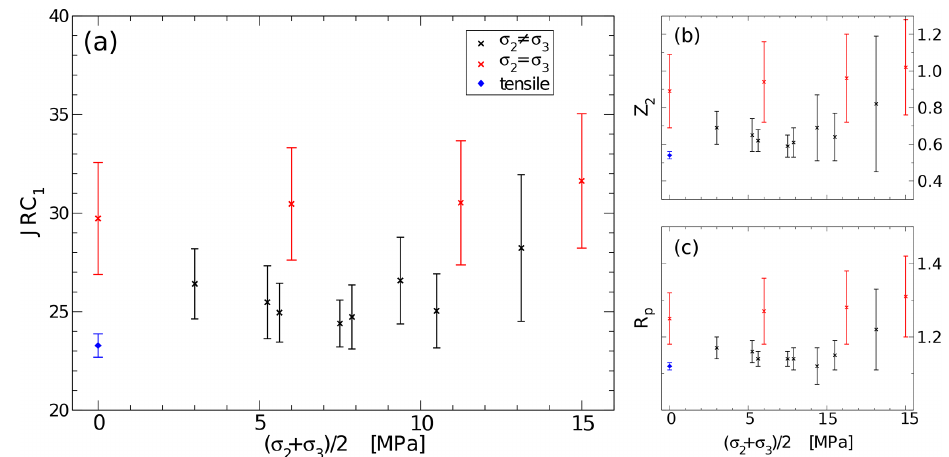
Figure 6. Geometric roughness measures for surfaces generated at different stress conditions in DEM models. Black: True triaxial com- pression, bed: Standard triaxial compression (transverse isotropic confinement), blue: unconfined extension. (a) Approximated JRC values calculated based on Eq. (5). (b) “Root mean square of the first deviation” Z 2 (Eq. 9). (c) “Profile elongation index” R p (Eq. 8). Error bars show standard deviation.